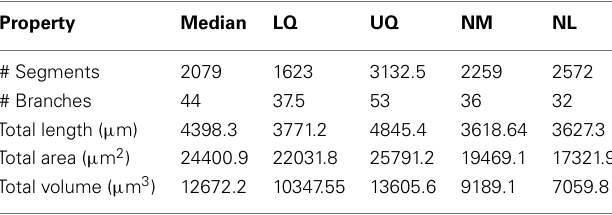
reconstructions compared to the Neuron_Morpho and Neurolucida